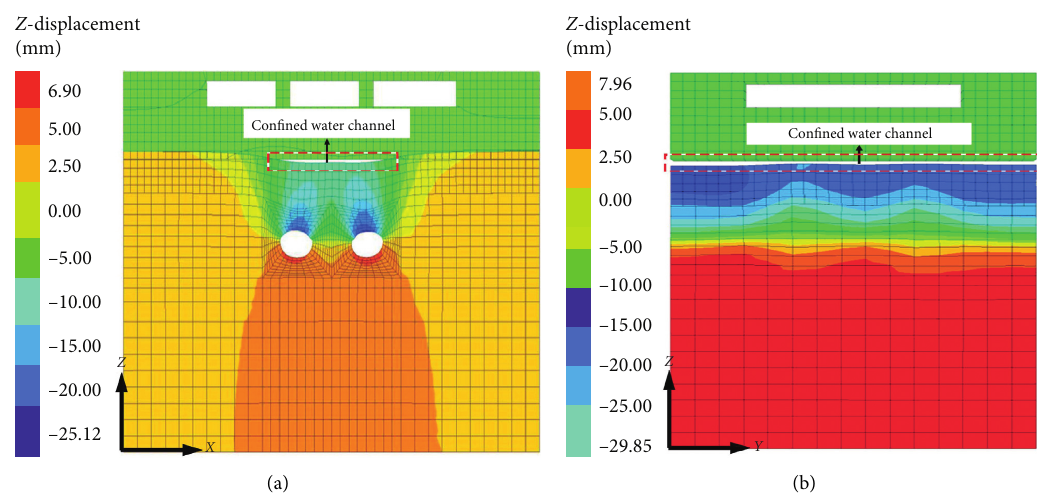
Figure 8: : Diagram of deformation. (a) Diagram of cross section; (b) diagram of longitudinal